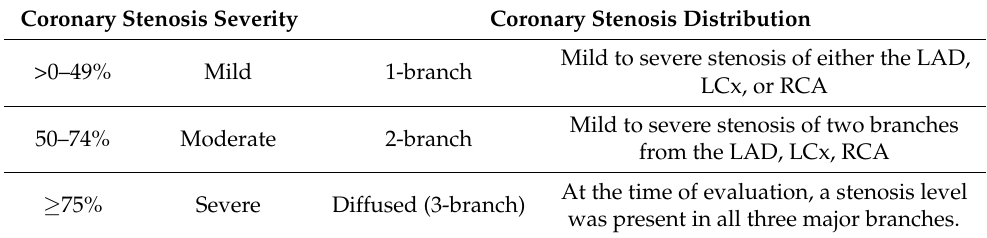
Table 3. Coronary stenosis criteria utilized in the